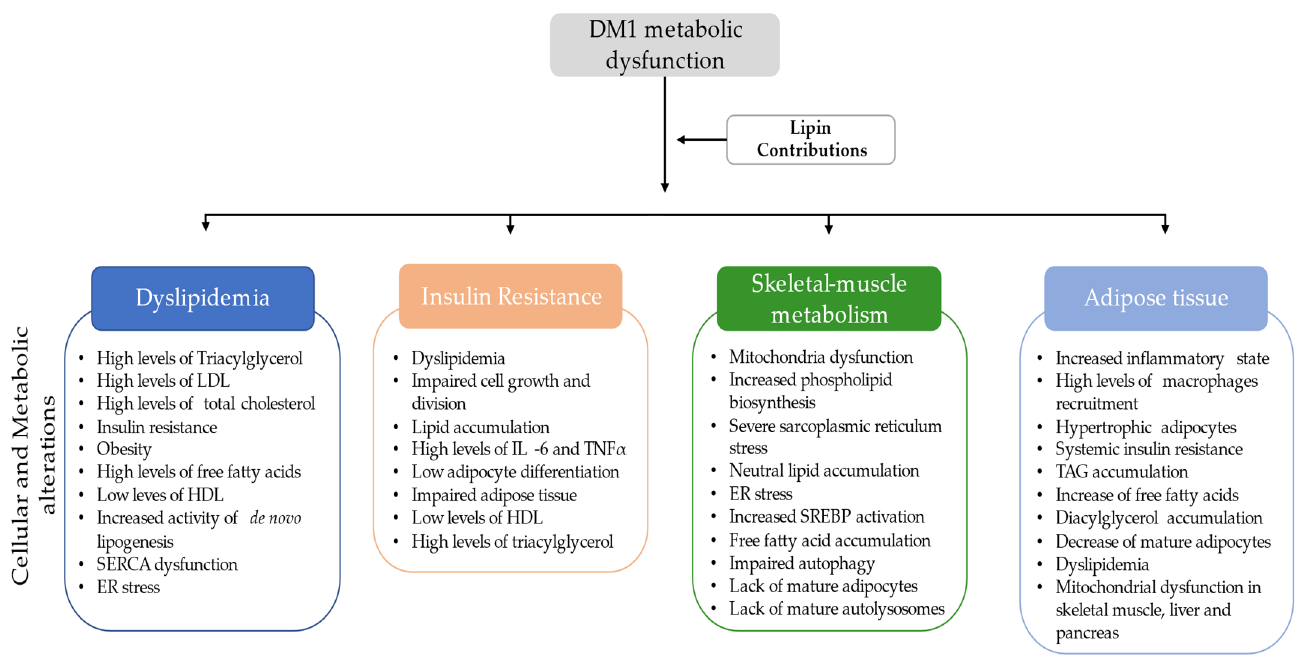
Figure 4. Summary of the potential contributions of lipin dysfunction in DM1. LDL—low-density lipoprotein; HDL—high-density lipoprotein; SERCA—sarco/endoplasmic reticulum Ca 2+ -ATPase; ER—endoplasmic reticulum; IL-6—interleukine-6; TNF α —tumour-necrosis factor- α ; SREBP—Sterol regulatory element-binding protein; TAG—triacylglycerol.